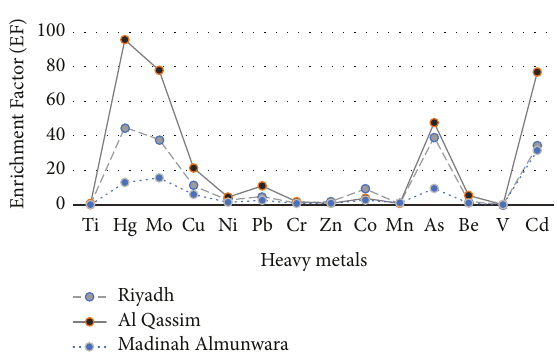
all heavy values elements found in the soil at site B of Riyadh, Qassim, and Medina regions. The Pollution Index (PI) values of Ti, Cu, Ni, Pb, Cr, Zn, Co, Mn, Be, and V ranged from 0.0010 to 0.9000 (PI < 1) with an average range between 0.0012 and 0.3704, which indicate that the soil is unpolluted. The PI value of Hg, Mo, and As of Riyadh and Medina ranged from 1.0000 to 1.6538 (PI > 1) with an average range between 0.8205 and 1.1375 which indicate that the soil is slightly polluted in these two regions, while the PI values of these elements of Qassim are PI < 1 which indicate that the soil is unpolluted. The value of As of Medina is 3.3333 (PI > 1) which indicate that the soil is strongly polluted, while its presence in the soil of the regions of Riyadh and Qassim is considered unpolluted. The PI value of Se is ranged from 6.7500 to 14.1667 (PI > 1) with an average of 10.0278, which indicate that the soil is very strongly polluted.